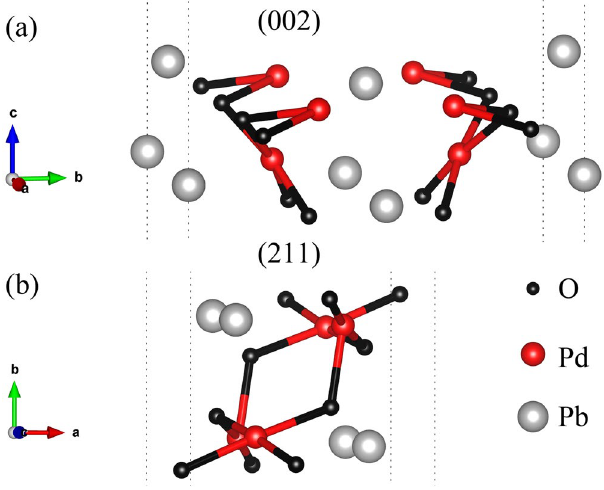
Figure 1. Side view of atomic structures of PbPdO 2 ultrathin films with ( a ) (002) orientation and ( b ) (211) orientation. Red, gray and black spheres represent Pd, Pb and O, respectively.